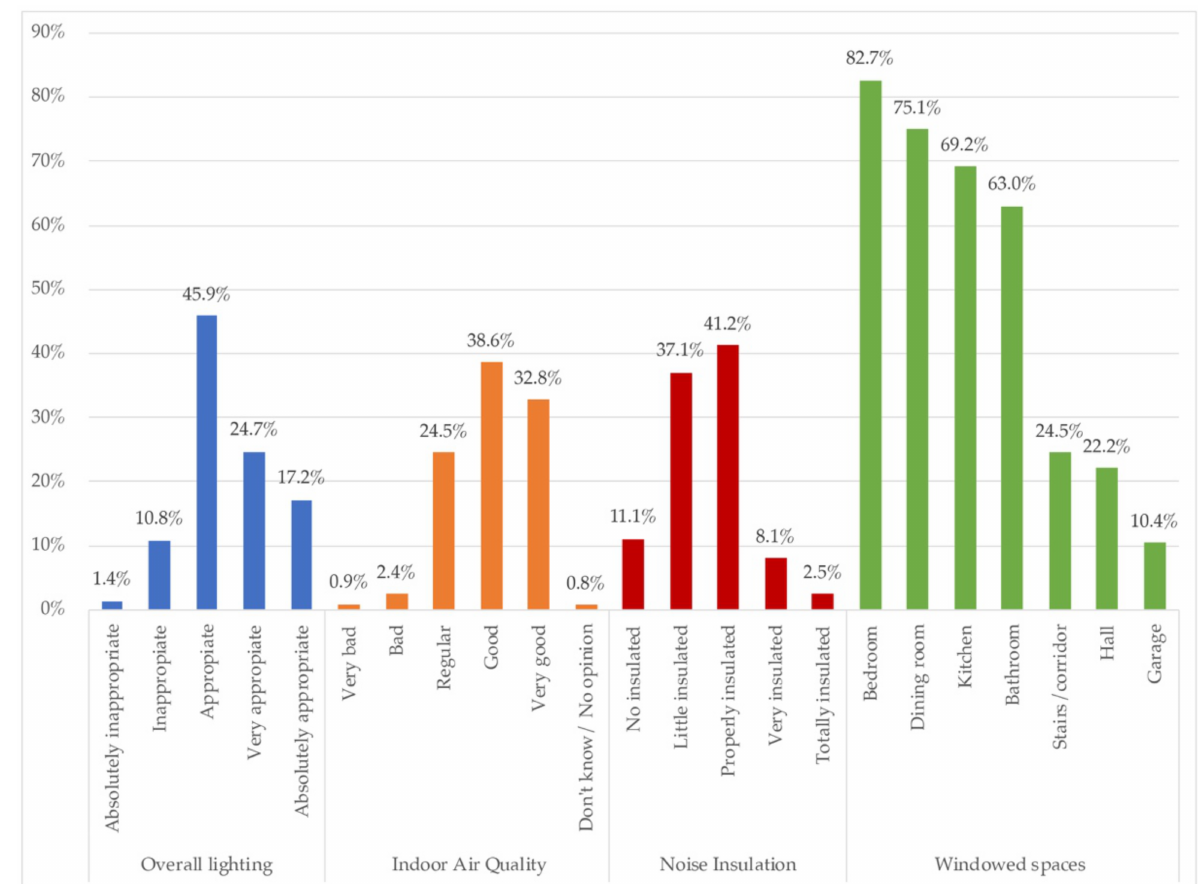
Figure 5. Indoor environment quality (lighting, air quality, noise insulation, and room